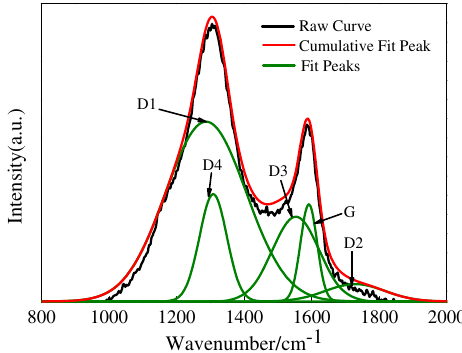
Fig. 8 Curve-fitted Raman spectrum of YCW semi-char with 5 wt% IWC loaded at 1000 (cid:3) C